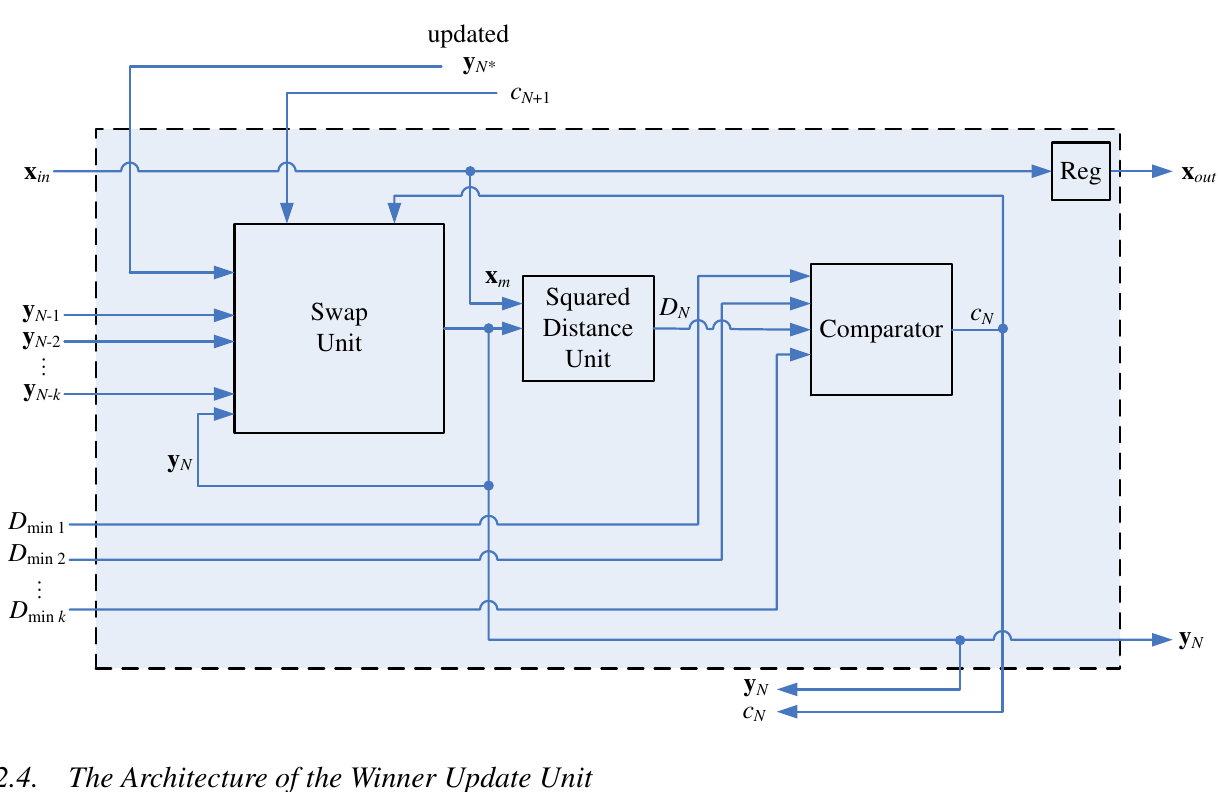
Figure 12. The architecture of stage N